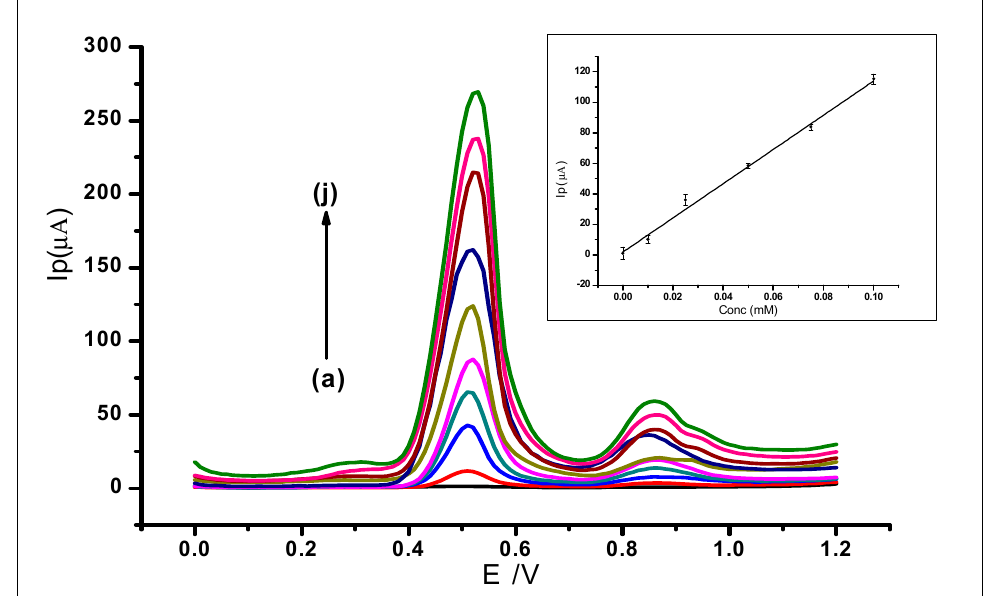
Figure 13. Di ff erential voltammograms of various concentrations of GA at ZrO 2 nanoparticles modified CPE in a 0.1 mol L − 1 phosphate bu ff er at 2.0, scan rate of 100 mVs − 1 , with voltammograms (a–j) that corresponds to the following concentrations: (a) Blank PBS, (b) 0.01 mmol L − 1 , (c) 0.025 mmol L − 1 , (d) 0.05 mmol L − 1 , (e) 0.075 mmol L − 1 , (f) 0.1 mmol L − 1 , (g) 0.25 mmol L − 1 , (h) 0.5 mmol L − 1 , (i) 0.075 mmol L − 1 (j) 1 mmol L − 1 .